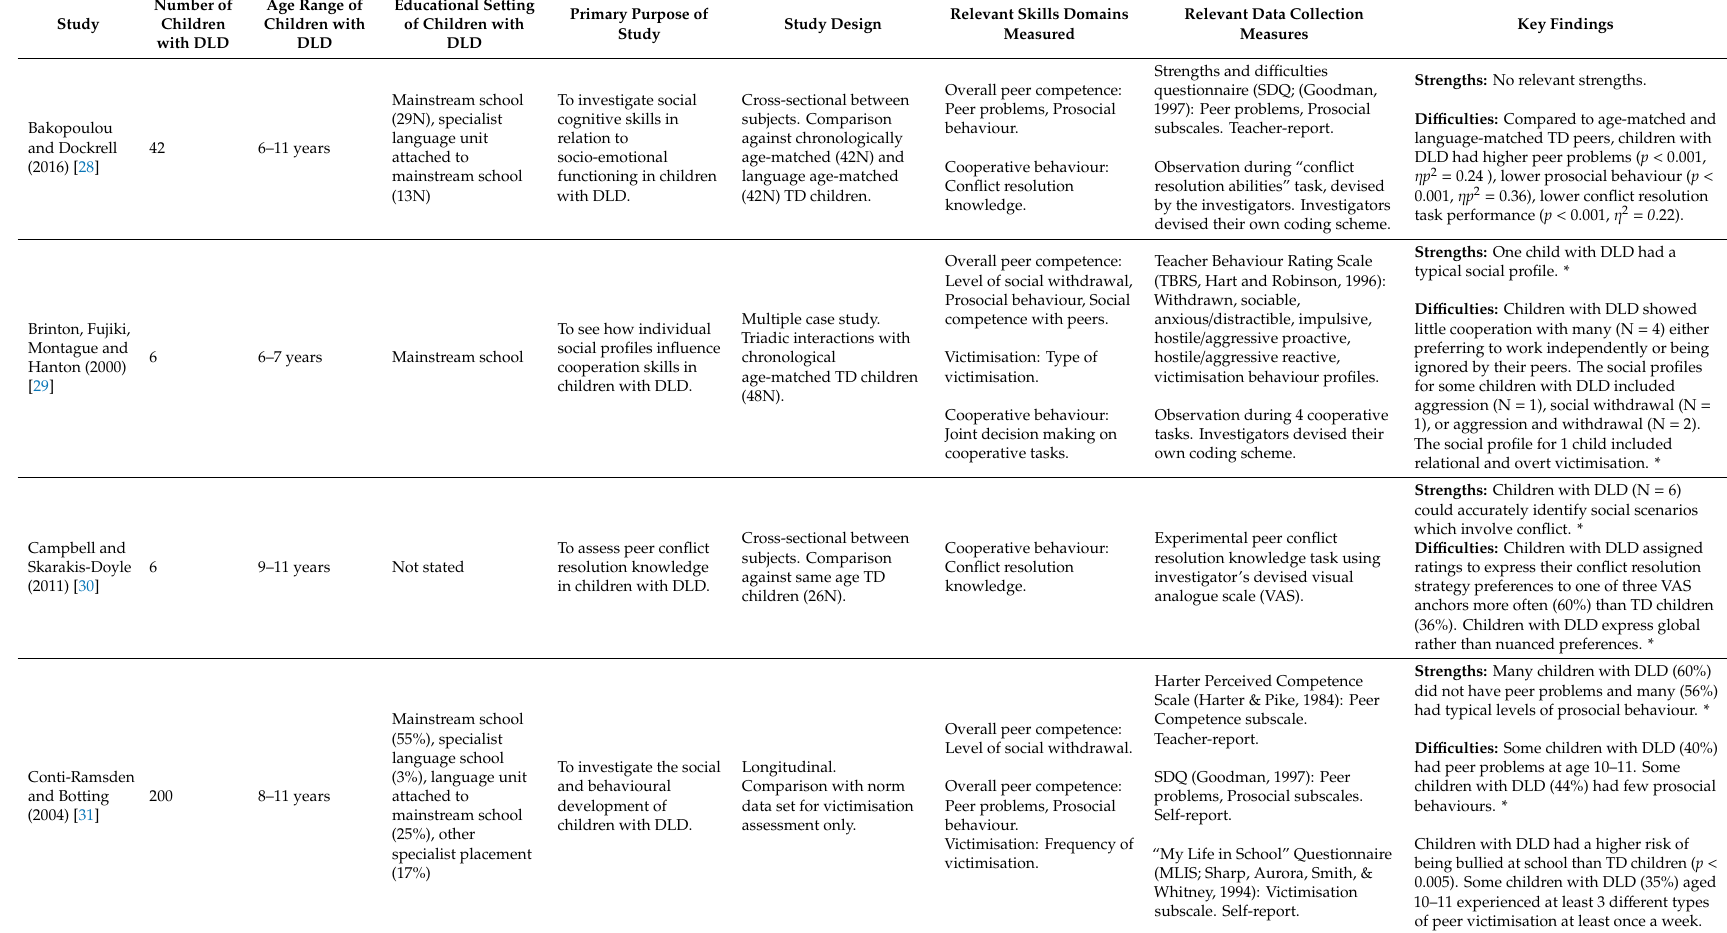
Table 2. Summary of